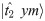
DSD realization of the annihilation reaction.Here, |t2^ym〉 and |t2^yp〉 correspond to the output species y
+ and y
−, respectively. Two fuels (ann and ann_1) with similar structures are used to ensure that the consumption rates of y
+ and y
− are balanced.